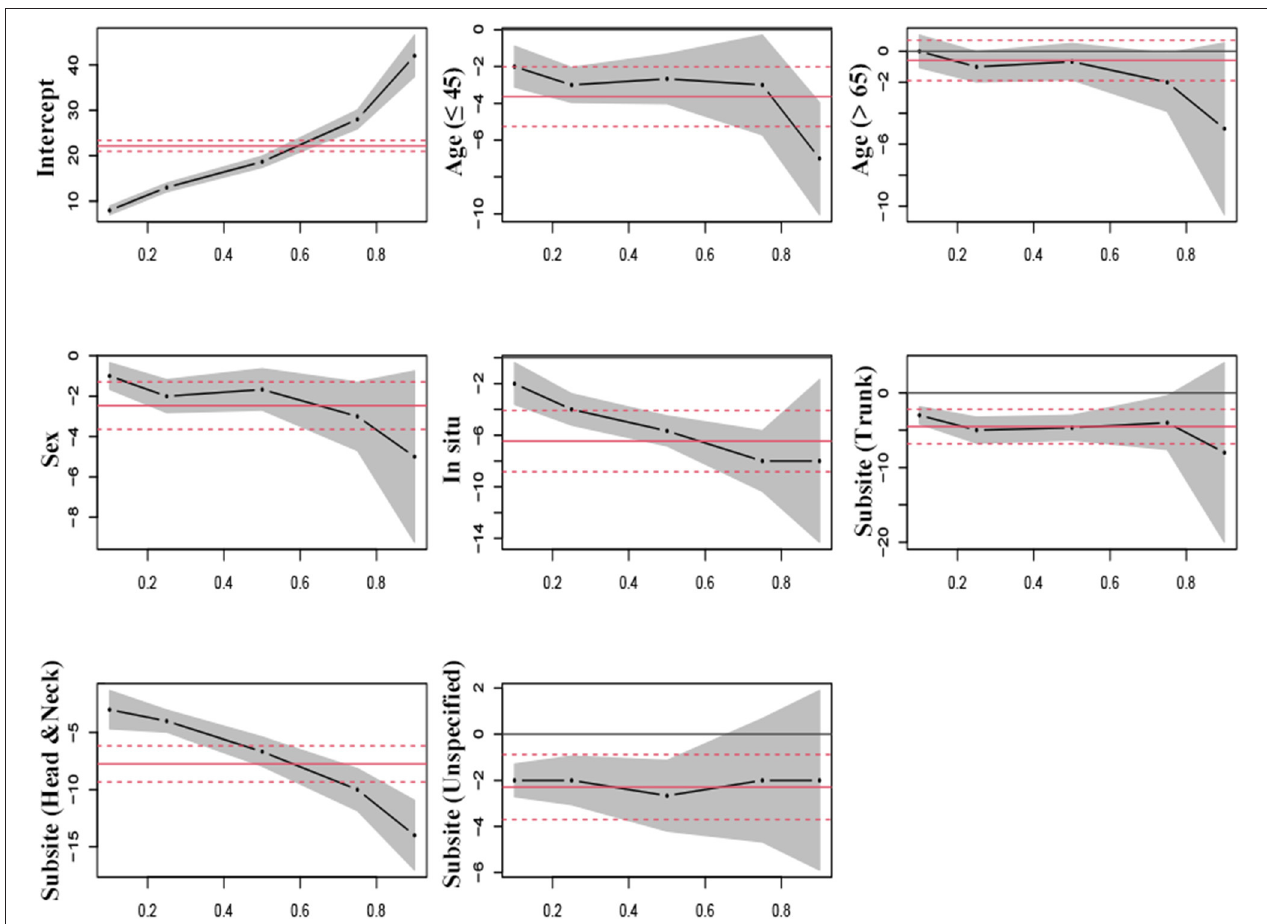
FIGURE 4 | Estimated parameters for length of hospital stay in patients with melanoma undergoing surgery by quantile regression versus linear regression. Black lines signify the point estimates by quantile regression at 0.1, 0.25, 0.5, 0.75, and 0.9 quantiles (gray bands signify 95% confidence intervals); and red lines signify the point estimates by linear regression (red dash lines signify 95% confidence